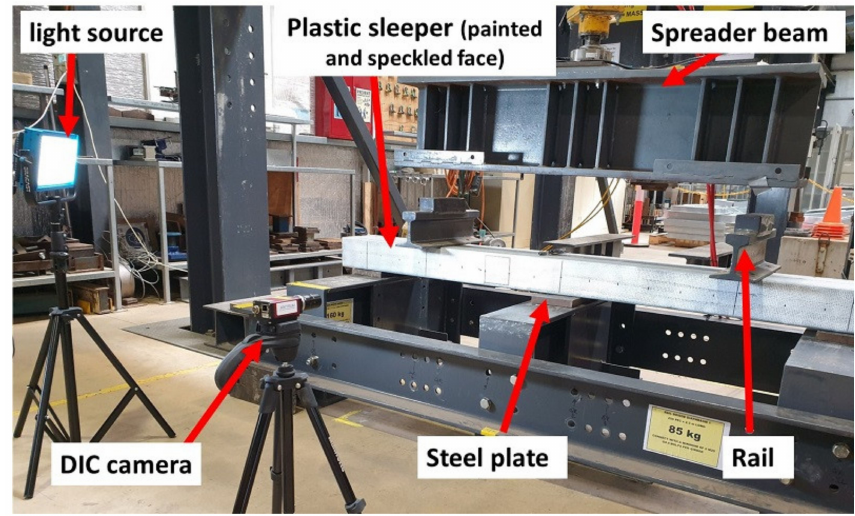
Figure 7. Actual test setup of the five-point bending test, showing the plastic sleeper. The deflected shape of the sleepers along their length was captured using the DIC camera. A screenshot of the DIC image for each sleeper type is provided in Figure 8. An LVDT instrument was also used to measure the rail seat displacements for validation of the measured displacement using the DIC. From the measured settlement at the middle support (using the DIC), the positive and negative bending moments can be calculated. The ratios of the positive-to-negative bending moments, compared to the BOEF, were then calculated and used as a basis to evaluate the most suitable test configuration that best represents the flexural behaviour of railway sleepers supported by ballast.